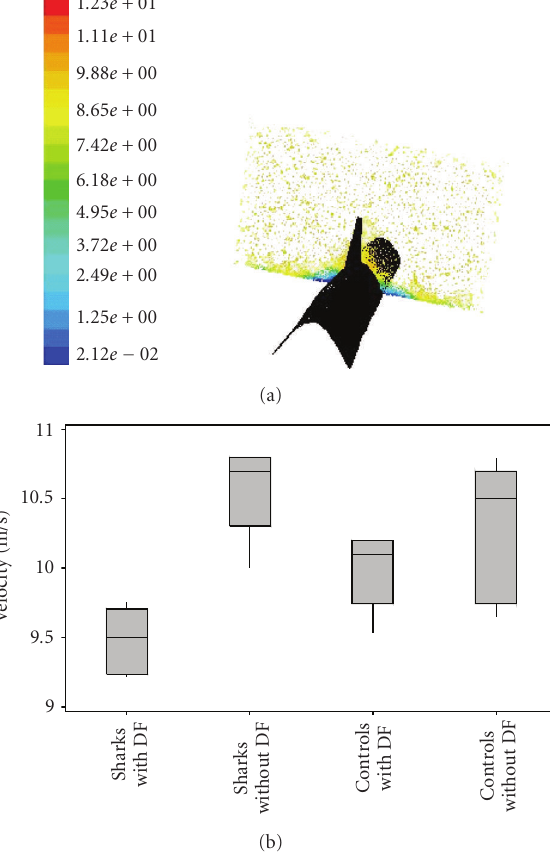
Figure 6: (a) Pathlines in the x - z plane along the lateral line of the body models of specimen A showing the channelling of the flow along the lateral line and the reduction in velocity magnitude. (b) Pathlines in the x - z plane along the equivalent position of the lateral line in specimen A for the control cylinder “a” showing the reduced bunching e ff ect of the pathlines near the model surface due to boundary layer e ff ects alone (pathlines coloured by velocity magnitude, ms − 1 ).